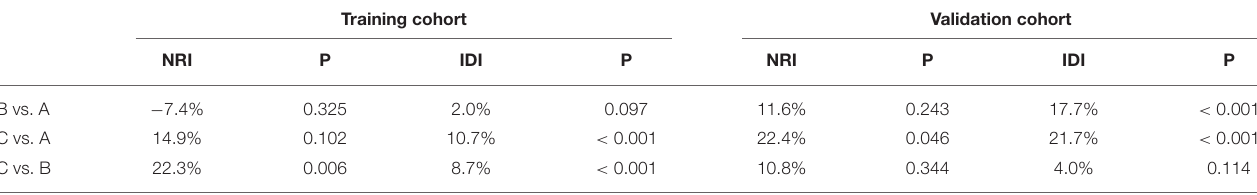
TABLE 1 | A comparison of discriminatory ability of model B and model C with model A using NRI and IDI in the training and validation cohort. Training cohort Validation